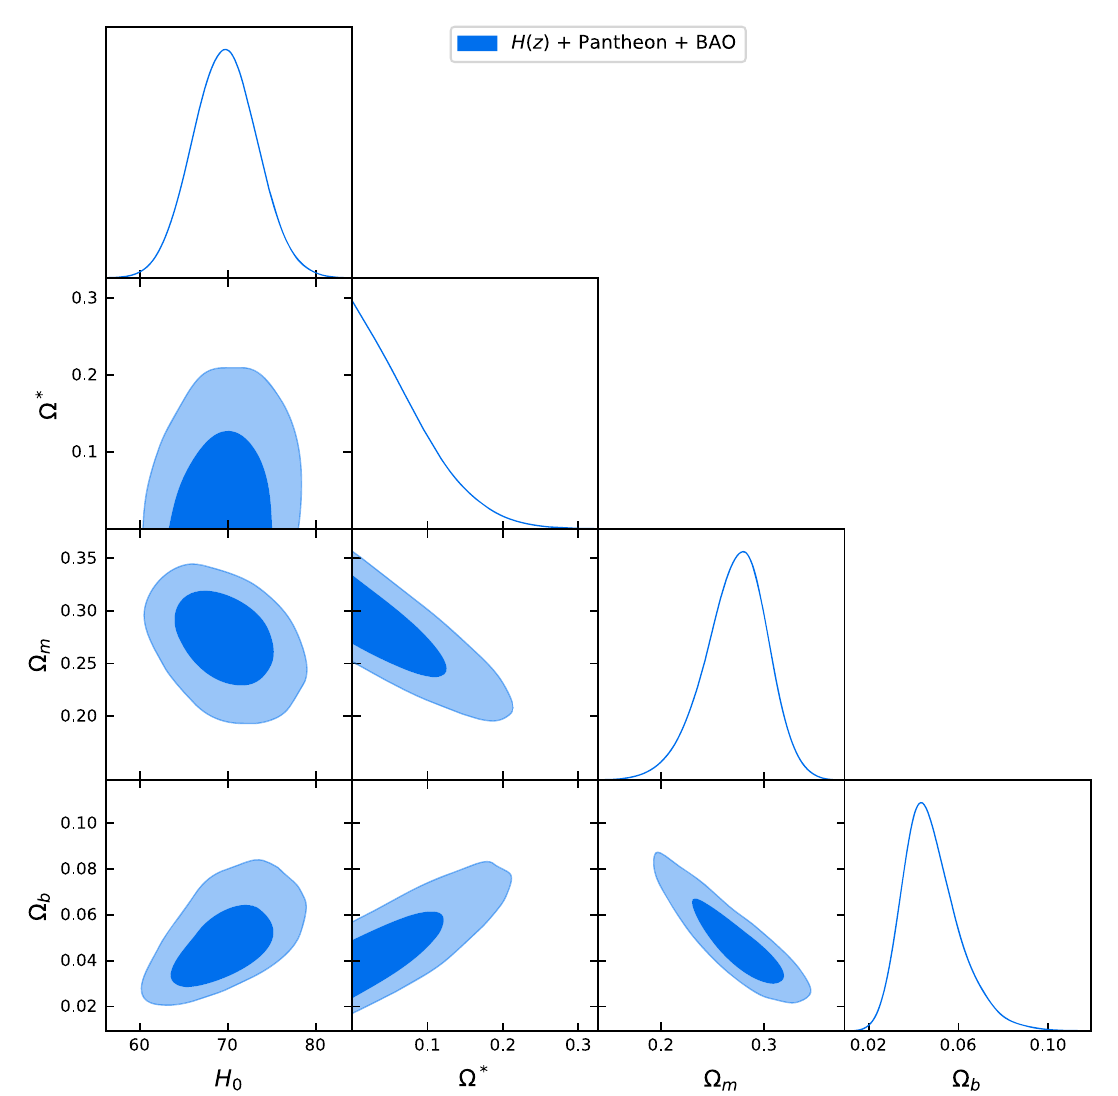
Fig. 4 Case II: Contours of the parameters H 0 , (cid:7) m , (cid:7) b and (cid:7) ∗ at 1 σ and 2 σ c.l. for the joint analysis of H ( z ) + SNe Ia (Pantheon) + BAO, with the prior (cid:7) ∗ ≥ 0